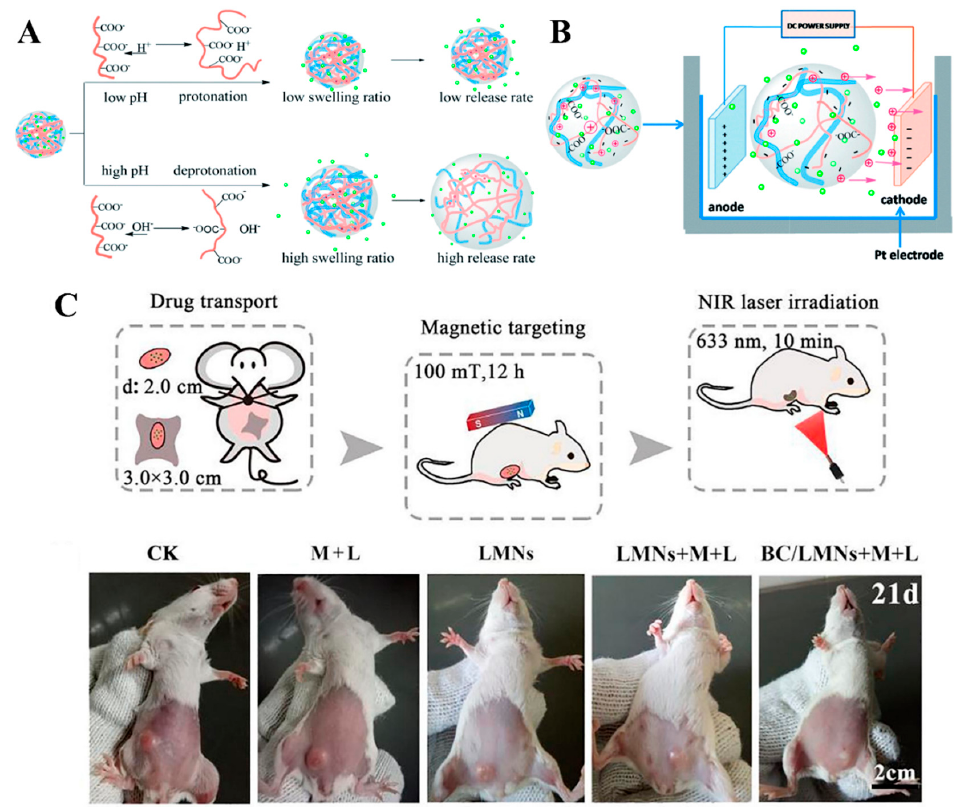
Figure 7. Schematic representation of ( A ) IBU drug release from nf-BC–SA scaffold at different pH conditions, ( B ) under electric field, and ( C ) schematic representation and digital photographs of in vivo efficacy of LMNs treated with tumor-bearing mice by five groups (CK (NS), LMNs, LMNs + M + L, and BC–LMNs + M + L). Reprinted with permission [138,139]. Copyright 2014 Royal Society of Chemistry and 2019 Elsevier.